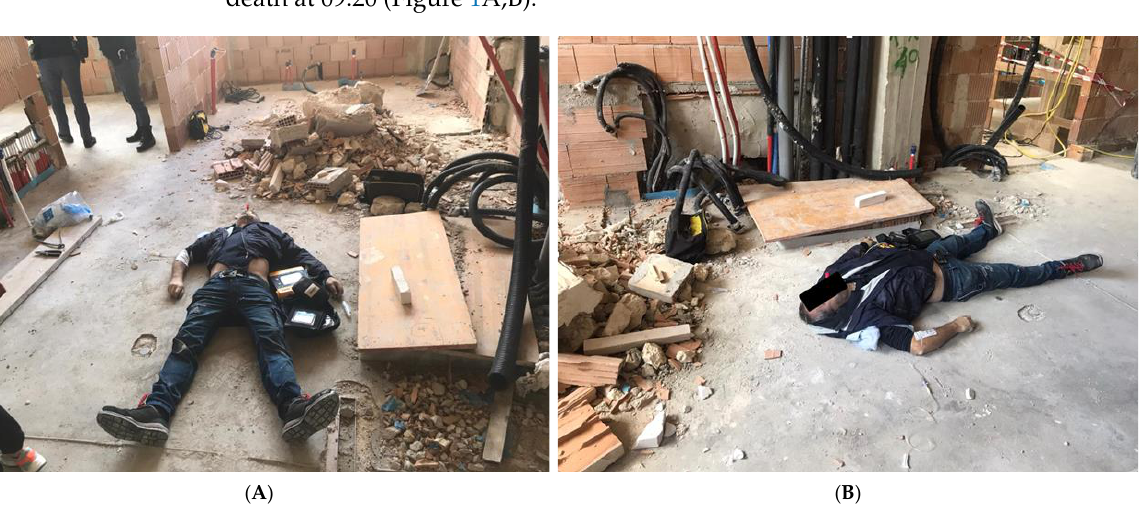
Figure 2. Macroscopical details of the heart and pericardium of the patient. Therefore, it was possible to trace the death to acute heart failure on an arrhythmic basis, which certainly appeared as a result of work efforts, in agreement also with the circumstantial finding.